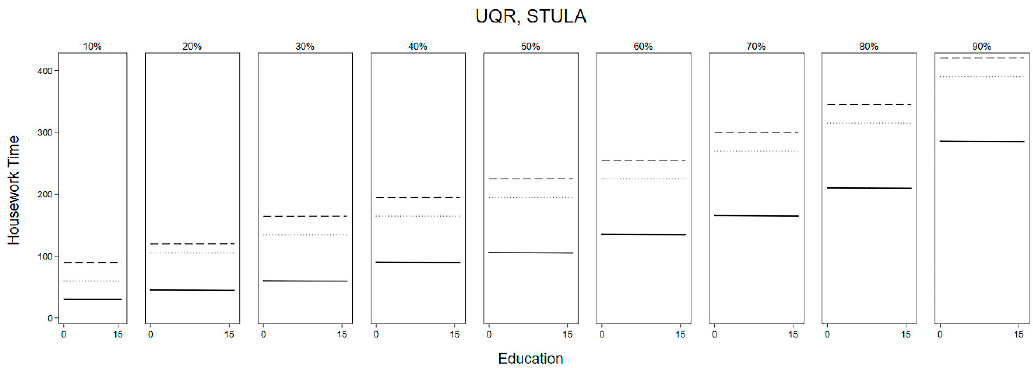
Figure 3. UQR Predicted Housework Time by Education over Deciles of Housework Participation, Japan.